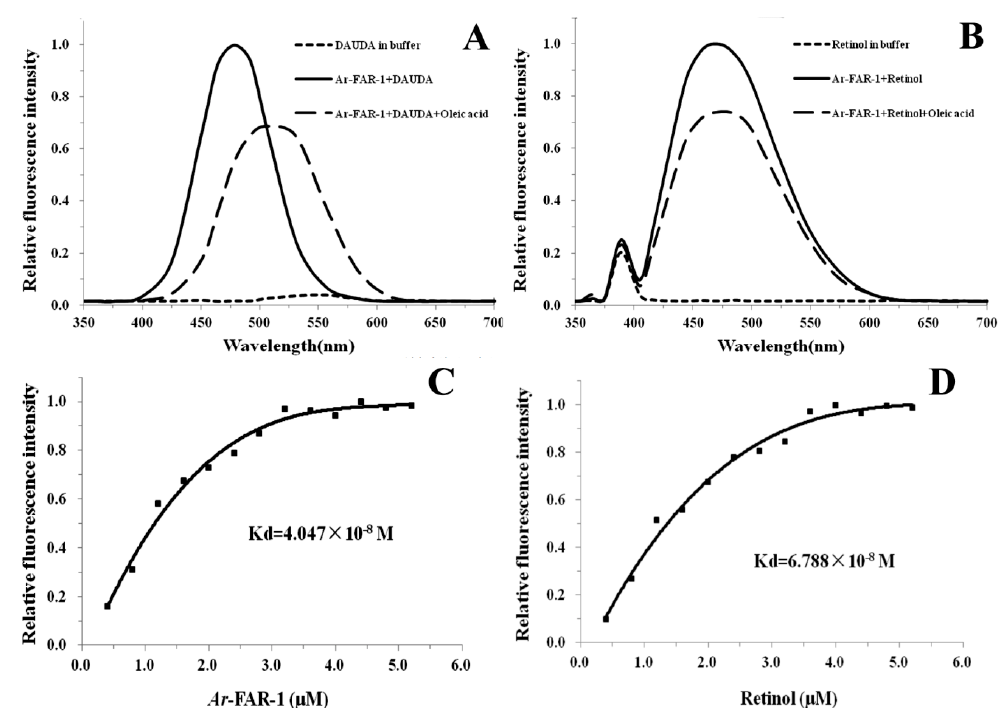
Figure 4. Ligand binding and fluorescent titration lipid binding analysis of r Ar -FAR-1. ( A ) Fluorescence emission spectra (excitation at 345 nm) of DAUDA alone or with the addition of r Ar -FAR-1. A change in DAUDA emission was observed after the addition of oleic acid to the r Ar -FAR-1 + DAUDA complex; the peak emission wavelengths for DAUDA were di ff erent. ( B ) Fluorescence emission spectra (excitation at 350 nm) of retinol in ethanol alone or after the addition of r Ar -FAR-1. The competitive e ff ect of oleic acid was also observed. ( C ) Changes in the relative fluorescence intensity (excitation at 345 nm) of DAUDA (10 mM) in the presence of increasing concentrations of r Ar -FAR-1. The curve was used to determine the dissociation constant (K d ) for the DAUDA / r Ar -FAR-1 interaction. ( D ) Change in the relative fluorescence intensity (excitation at 350 nm) of 10 mM r Ar -FAR-1 in the presence of increasing concentrations of retinol. The curve was used to derive the equilibrium dissociation constant (K d )